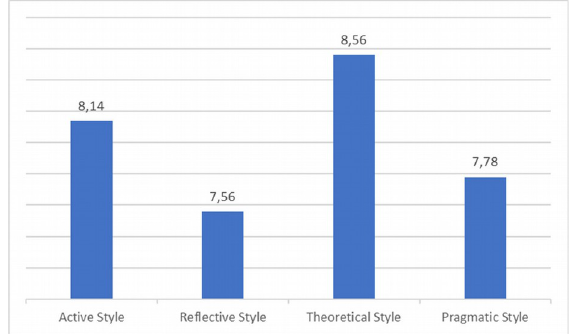
Figure 16. How would you rate the Flipped Classroom experience from 1 to 10?